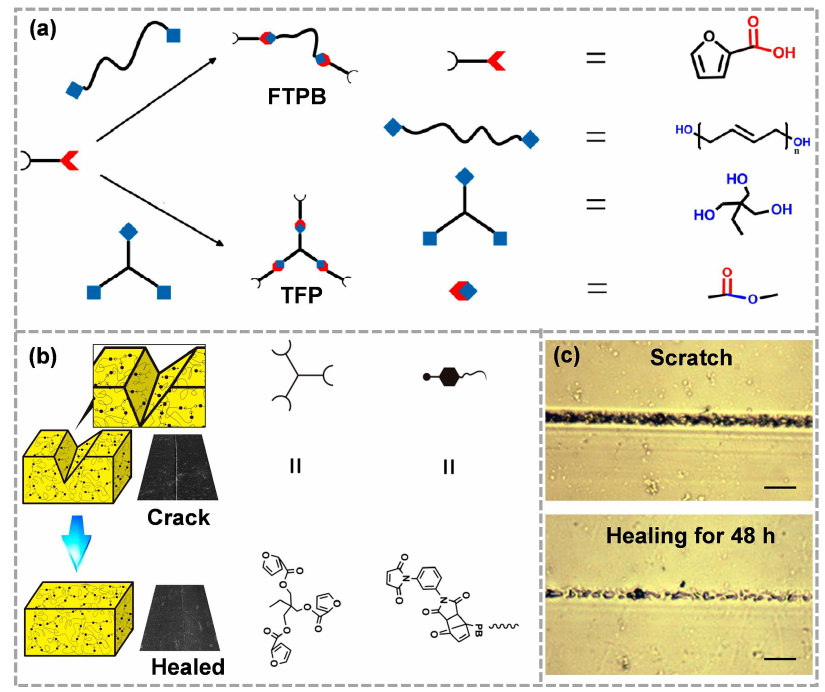
Figure 2. ( a ) Synthetic route of FTPB and TFP, ( b ) the self-healing process of TFP-FTPB-PDMI film and ( c ) the corresponding optical microscope images (reproduced from Ref. [57] with permission; Copyright MDPI, 2017).